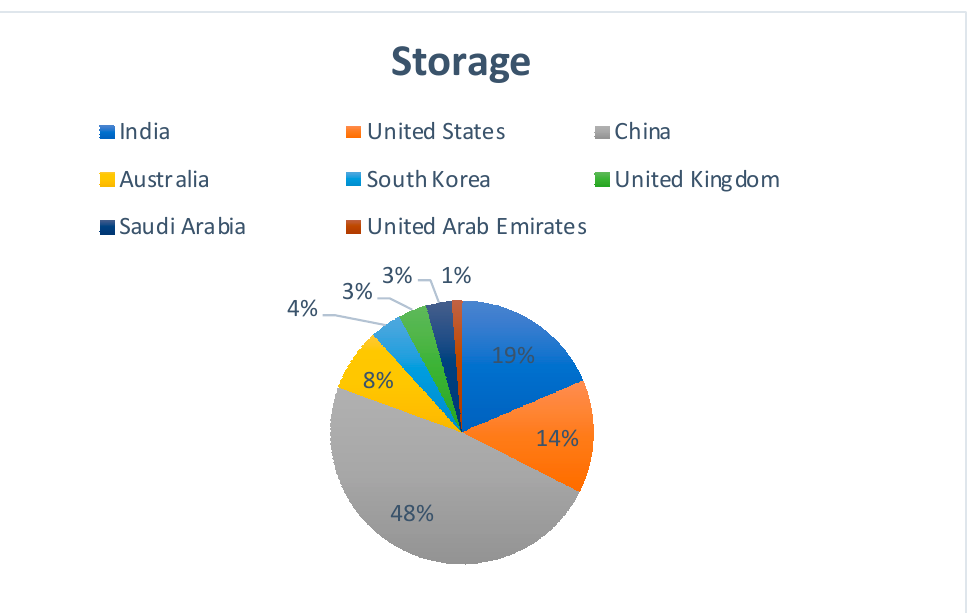
Figure 13. Region-specific publication distribution for the impact of Blockchain–Cloud integration on Cloud Storage.